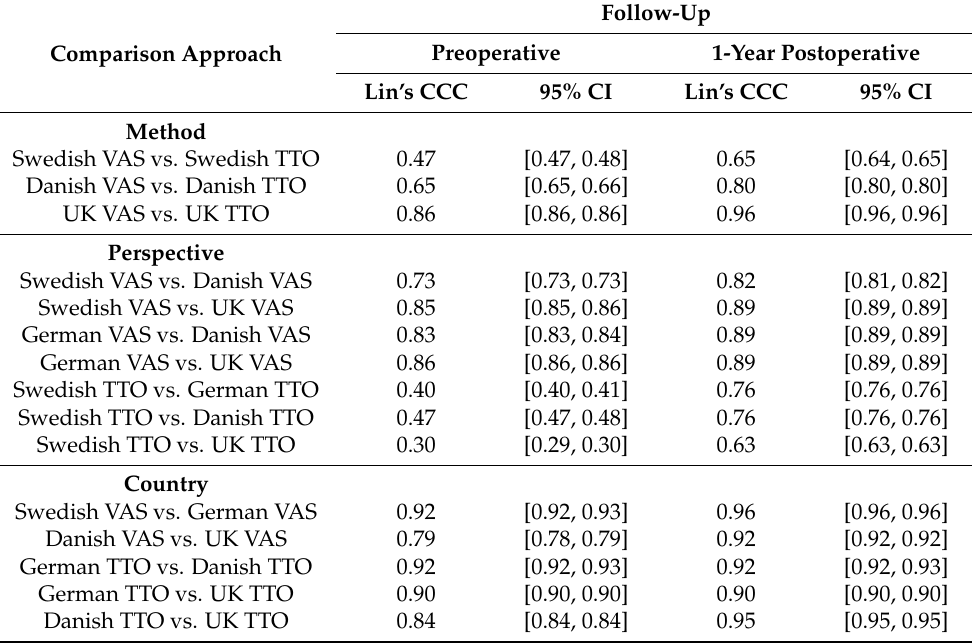
Table 2. Lin’s CCC test between EQ-5D-3L indices based on the value sets pre- and 1 year postopera- tively ( n =